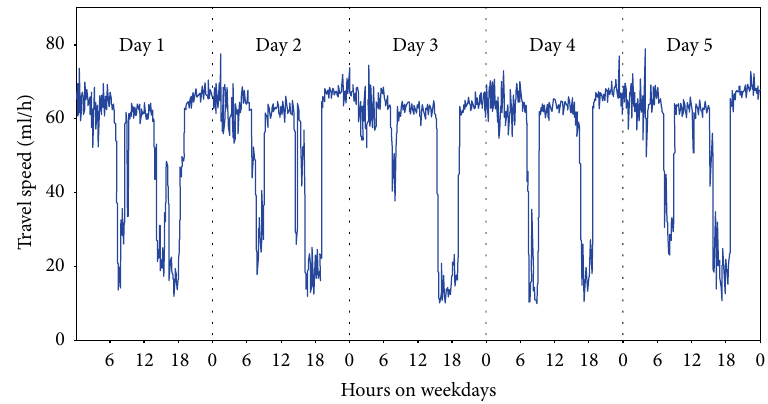
Figure 4: Periodic pattern of speed at station C during representative